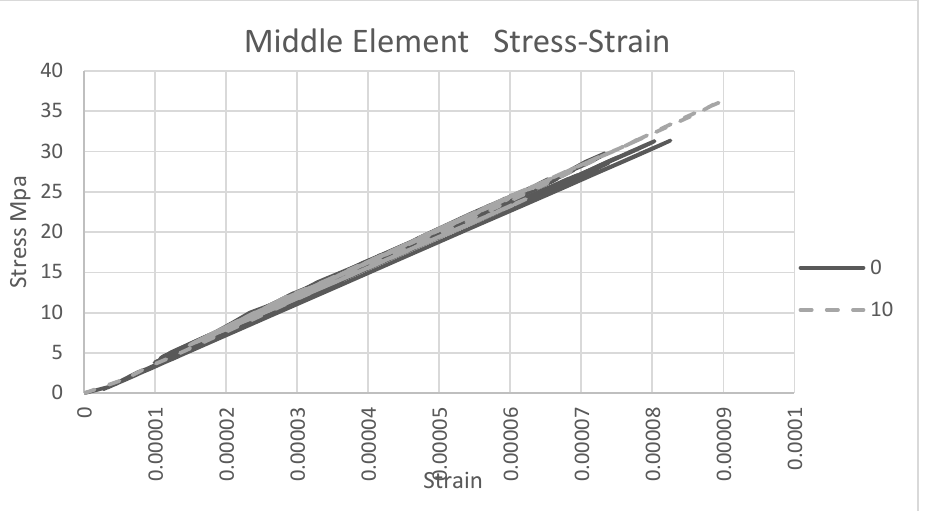
Fig. 17. The stress-strain curve in the joint node